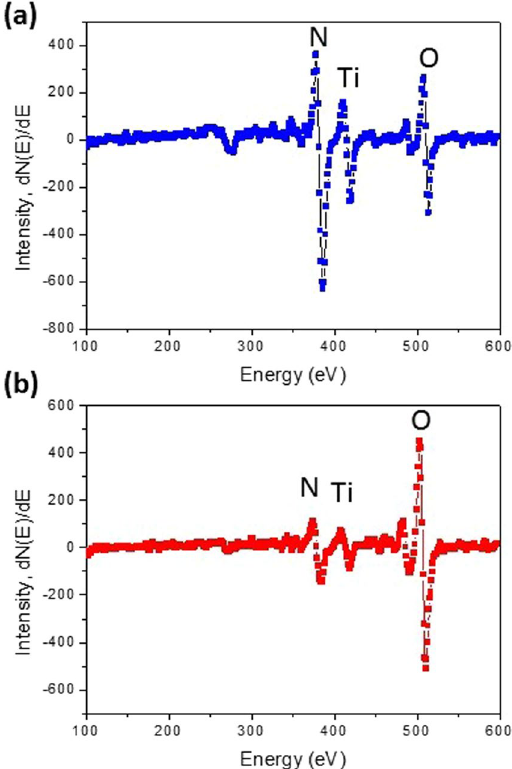
Figure 6. Auger survey spectra of the 20 nm TiN-based layers with the nominal oxygen doping percentage ( DP O ) of ( a ) 0% and ( b )